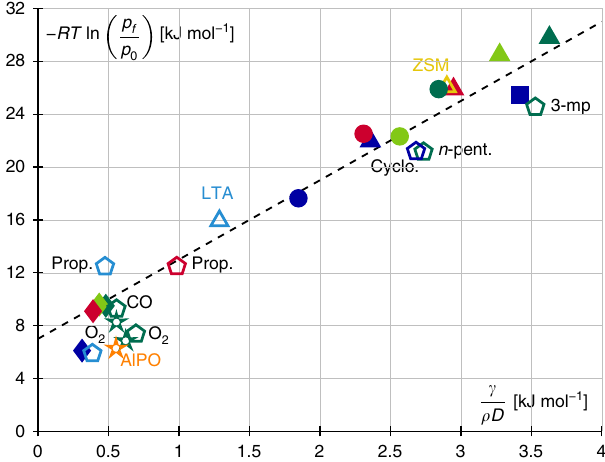
Fig. 4 Master curve and generic scaling. Chemical potential μ ∼ RT ln( p f / p 0 ) at which porosity fi lling occurs as a function of the capillary energy γ / ( ρ D ) for different fl uids in different zeosils for σ / D > 1.4. Filled symbols correspond to our molecular simulation data while open symbols correspond to available experimental data, with 2 additional matrices (light blue LTA, yellow ZSM-11, orange AlPO 4 -5) and 6 additional fl uids (pentagons except for Ar shown with stars) Argon (Ar), propylene (prop.), carbon monoxyde (CO), oxygen (O 2 ), cyclohexane (cyclo.), 3- methylpentane (3-mp), n -pentane (n-pent). The dashed line denotes a linear relationship with μ ∼ 6 γ / ρ D . The experimental data are taken from the following references: Ar/MFI at 77 and 87.3 K 43,44 , n -C6/LTA 45 , n -C6/ ZSM-11 46 , propylene/LTA et CHA 47 , O 2 and CO/LTA and MFI 48 , cyclo- C6/BEA 49 , 2-MP/MFI 50 , n -C5/MFI 51 , Ar/AlPO 4 -5